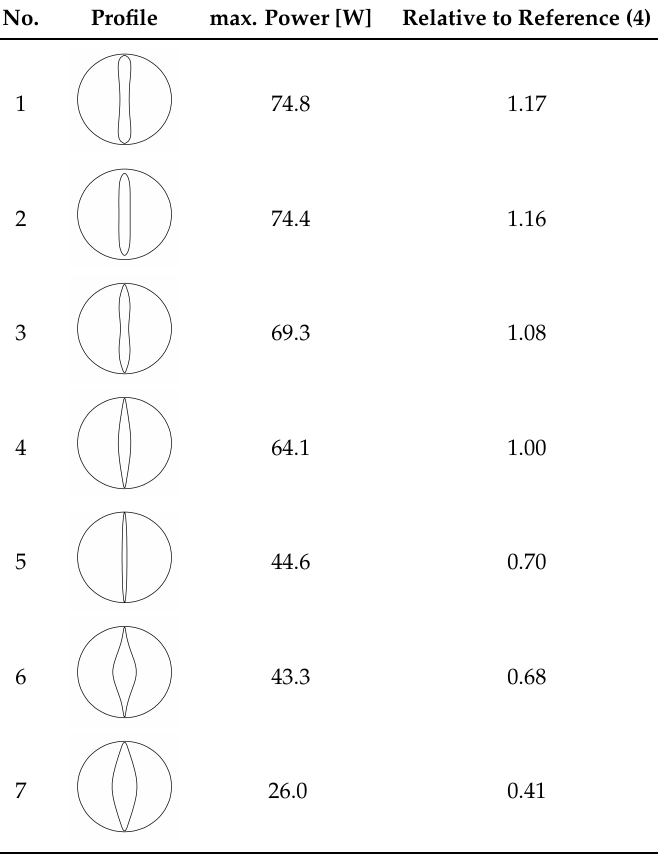
Table 3. Performance comparison of different blade profiles.